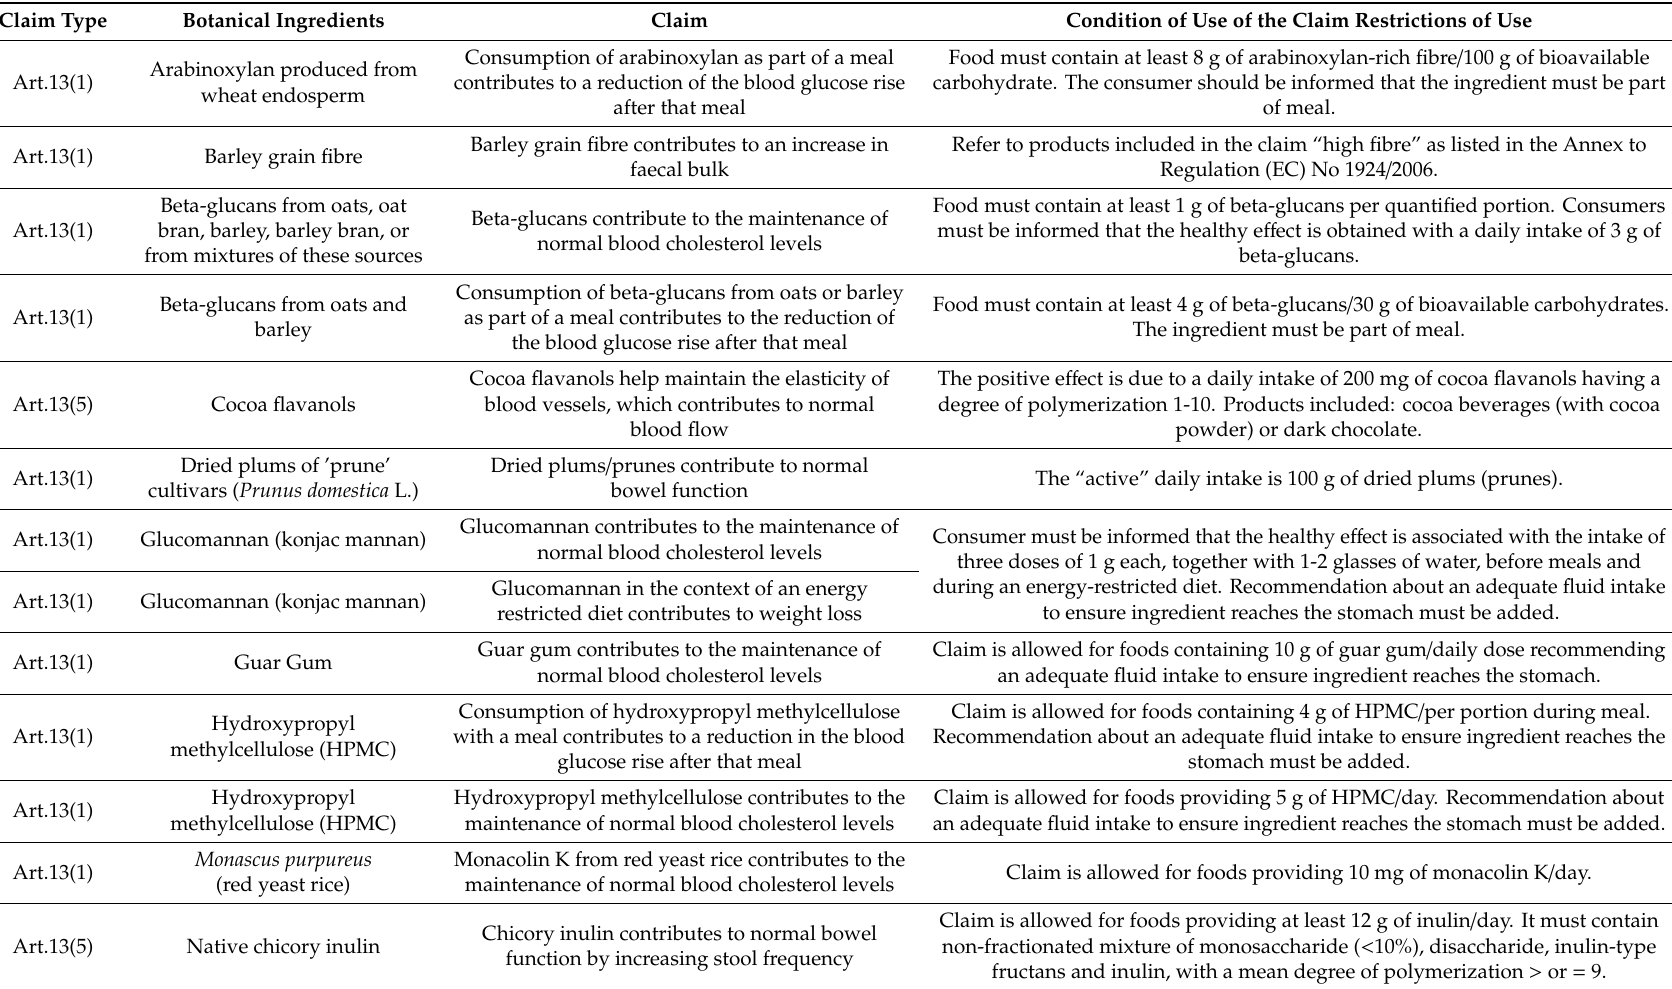
Table 1. List of main claims allowed in the EU for plant (botanical) ingredients contained in, or added to, functional food or food supplements